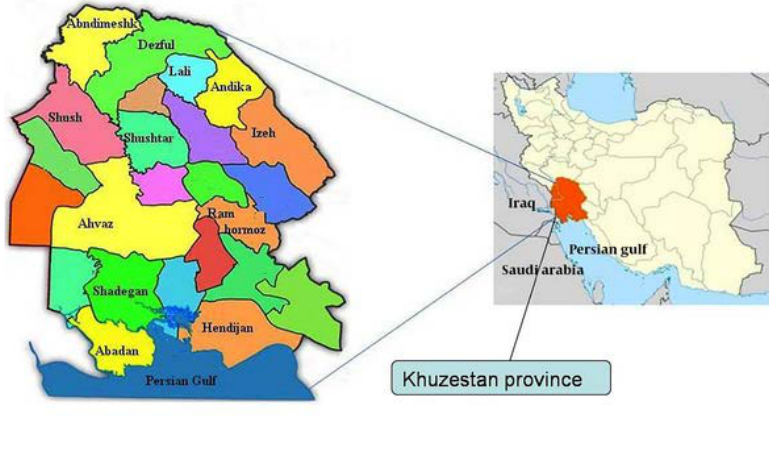
Fig. 1. Geometry of province